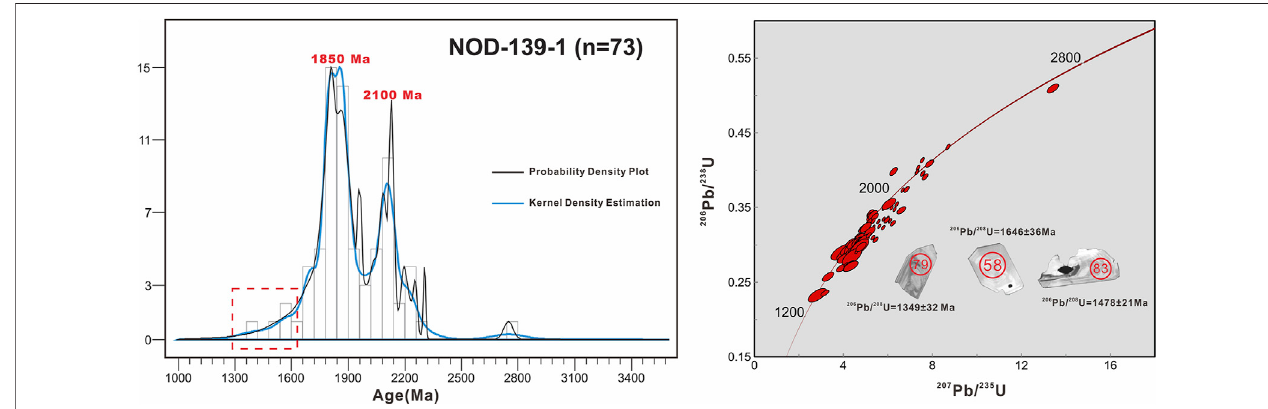
FIGURE 2 | The cumulative frequency and Concordia diagrams of the zircon age of the sandstone from the Majiahe Formation (NOD-139-1).